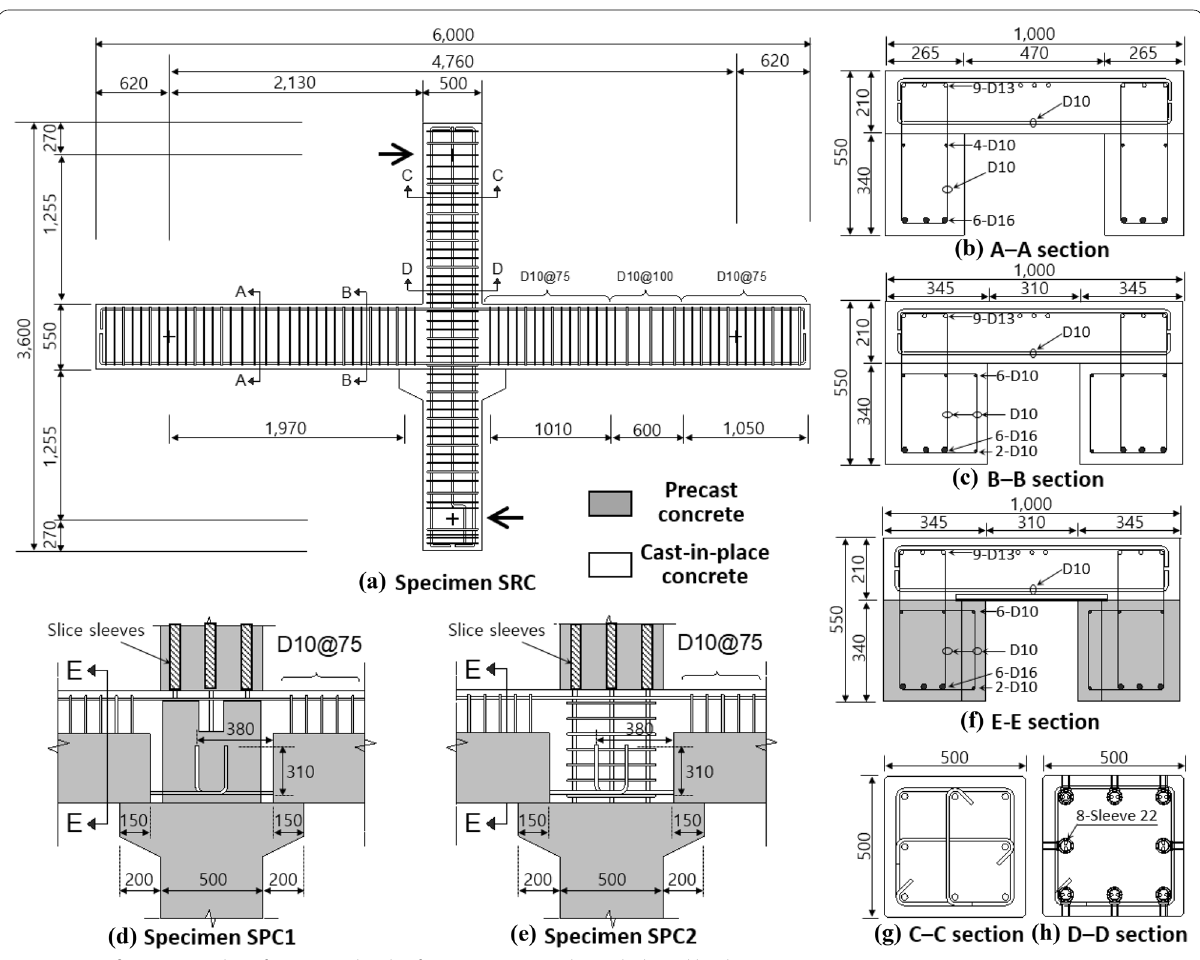
Fig. 13 Configuration and reinforcement details of test specimen under cyclic lateral